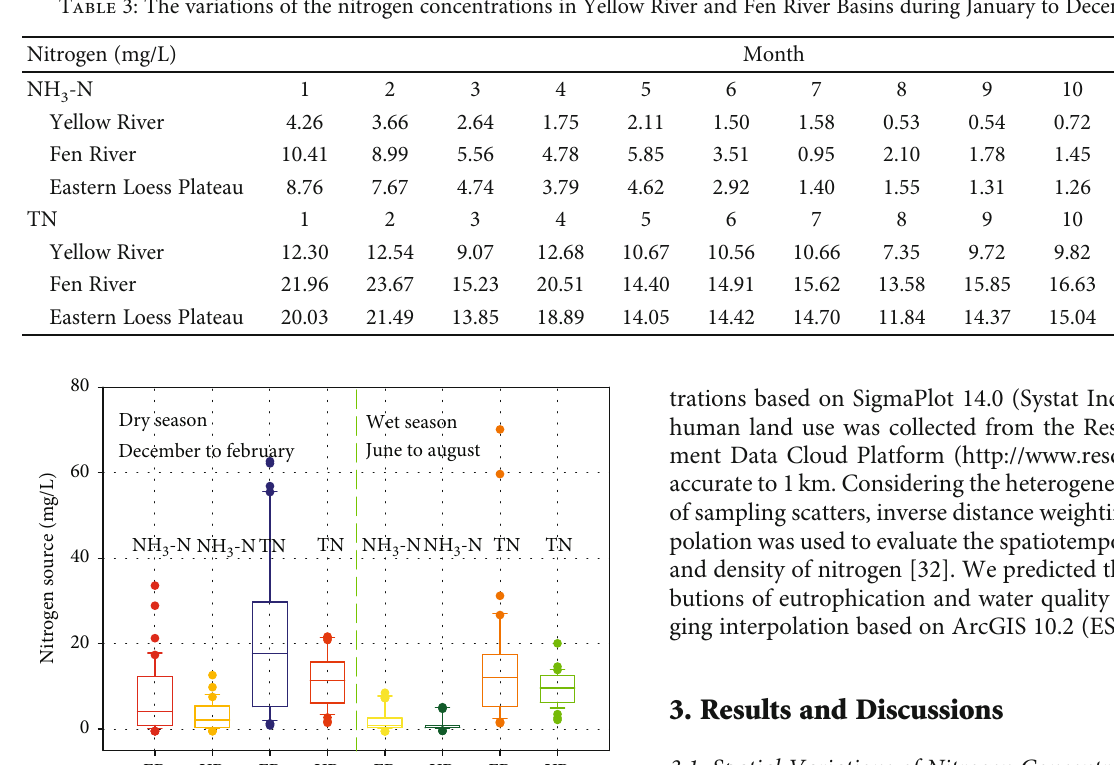
-N and TN concentrations in 3